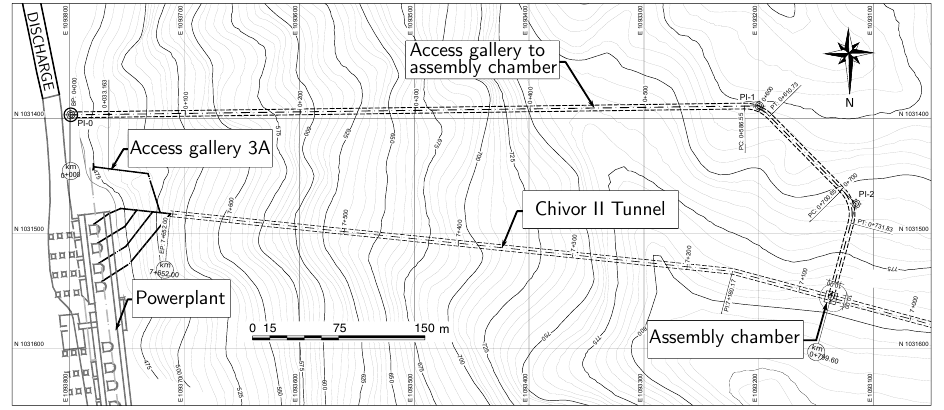
Figure 2. Chivor II tunnel. Access gallery and assembly chamber for the installation of the new lining.